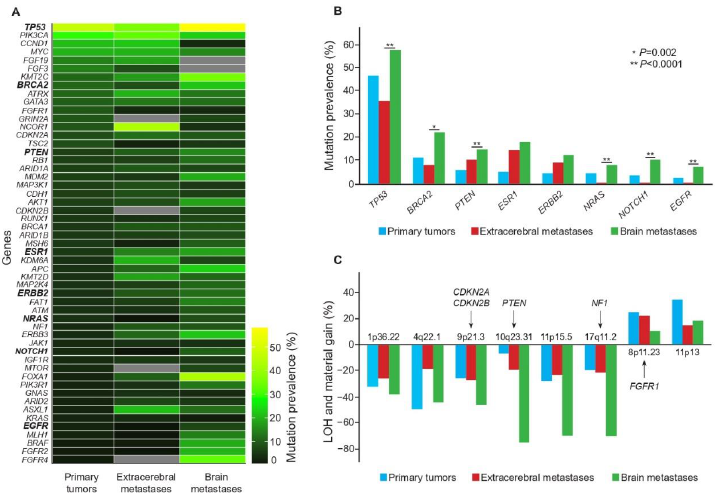
Figure 2. Gene mutation prevalence, loss of heterozygosity and copy number alterations in primary tumor, extracerebral metastases and brain metastases. Panel ( A ) shows a heatmap plot for the prevalence of gene mutations according to the tumor site (primary tumor, extracerebral metastases and brain metastases). Panel ( B ) shows the increased prevalence of gene mutations in brain metastases for 8 genes: TP53, BRCA2, PTEN, ESR1, ERBB2, NRAS, NOTCH1, EGFR . p -values reported here corresponded to those of Table 1 and of the pairwise comparison of gene mutation prevalence between brain metastases and extracerebral metastases. Panel ( C ) shows the loss of heterozygosity and material gain identified in breast cancer brain metastases. Table 1. Pairwise comparison of prevalence of gene mutations according to the tumor site. p -Value for Pairwise Comparisons of Mutation Prevalence Primary Tumors vs. Primary Tumors vs. Extracerebral Metastases vs. Brain Gene Extracerebral Metastases Brain Metastases Metastases